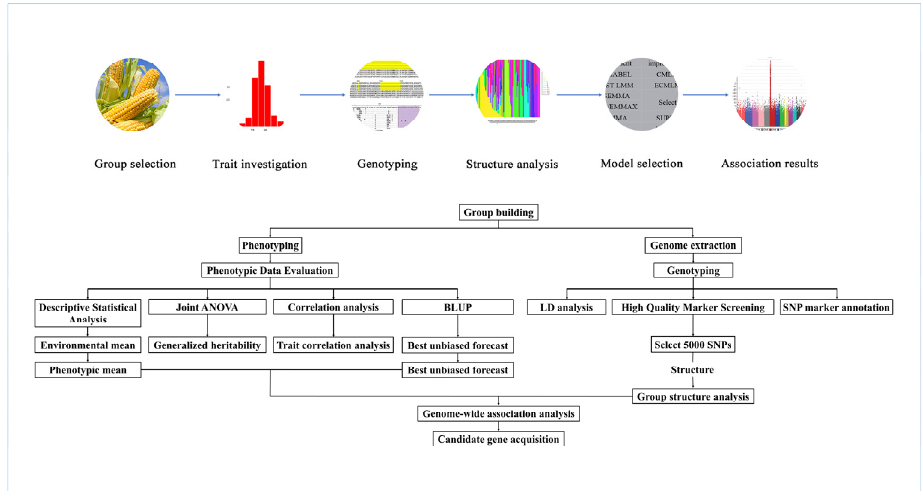
Figure 4. Schematic diagram of the GWAS process.